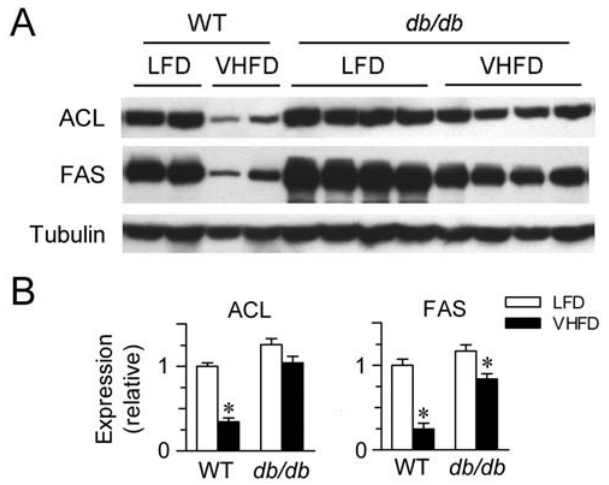
Figure 4. Attenuation of high-fat diet-induced suppression of hepatic lipogenic enzymes in db/db mice. (A) Western immunoblot analysis of ACL and FAS protein levels in the liver of WT and db/db mice fed LFD vs. VHFD for 4 weeks. (B) Quantification of the relative protein levels in (A) after normalization to tubulin as the loading control, shown as mean 6 SEM (n=2–4/group). * p , 0.05 vs. LFD-fed mice of the same genotype.